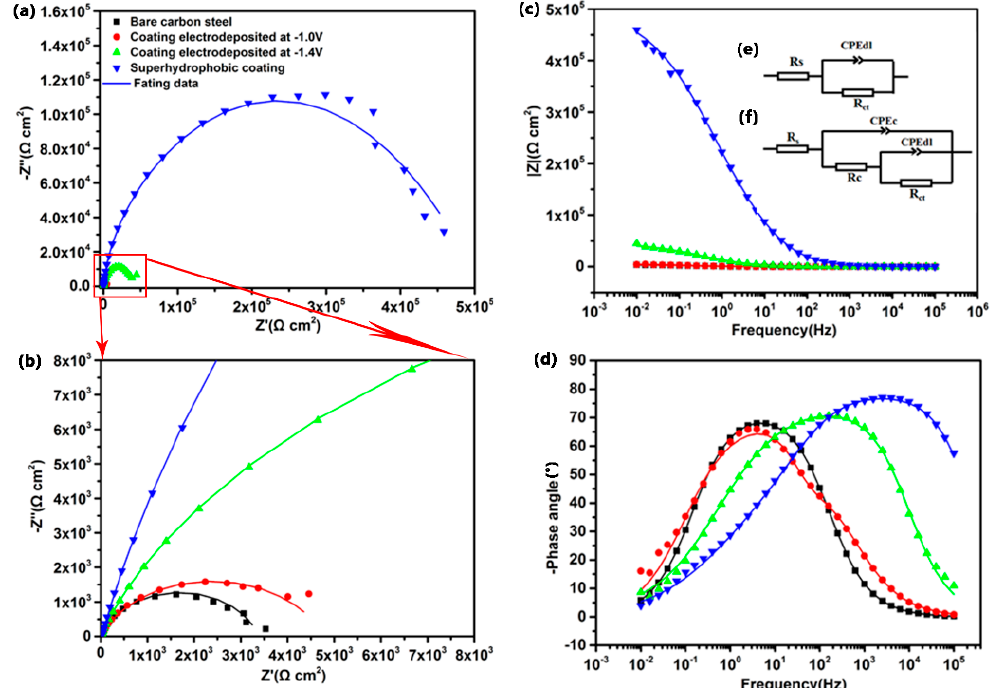
Figure 8. EIS results of the bare carbon steel, Co–Ni coating deposited at − 1.0 and − 1.4 V, and super-hydrophobic Co–Ni coating deposited at − 1.7 V in 3.5 wt.% NaCl solution after immersion for 1 h: ( a ) Nyquist plots; ( b ) high-resolution Nyquist plot in ( a ) marked with red box; ( c ) bode − | Z | versus frequency plots; and ( d ) bode-phase angle versus frequency plots. ( e ) Equivalent circuits for simulating EIS results of bare carbon steel. ( f ) Equivalent circuits for simulating EIS results of the Co–Ni coating deposited at − 1.0 and − 1.4 V, and the super-hydrophobic Co–Ni coating deposited at − 1.7 V.